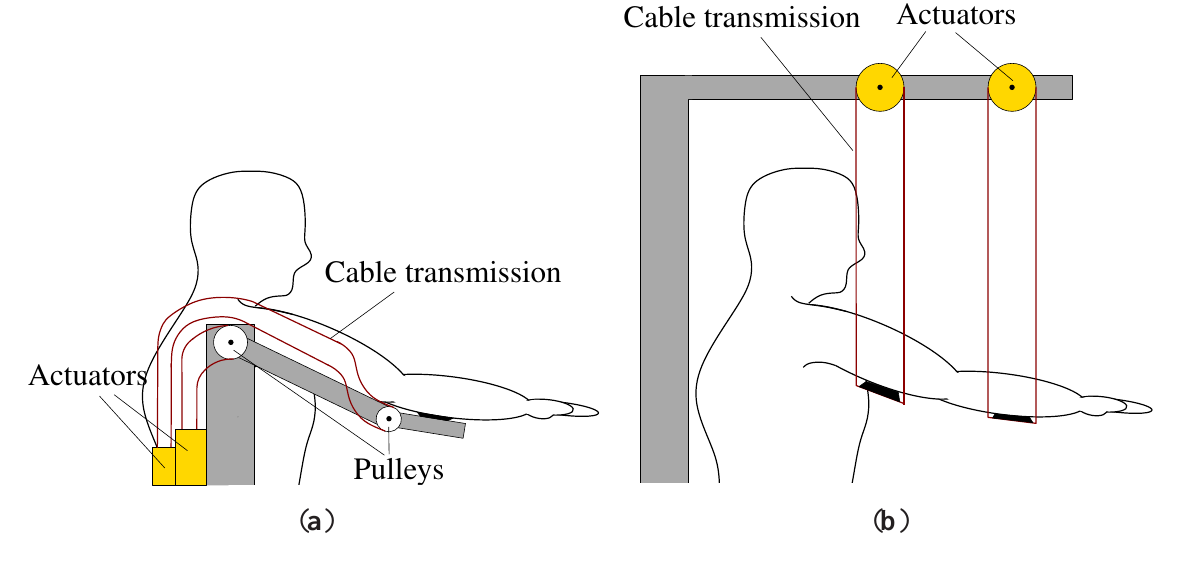
Figure 3. Schematic examples of external positioned actuation configuration for ( a ) placed on the stationary part and ( b ) cable